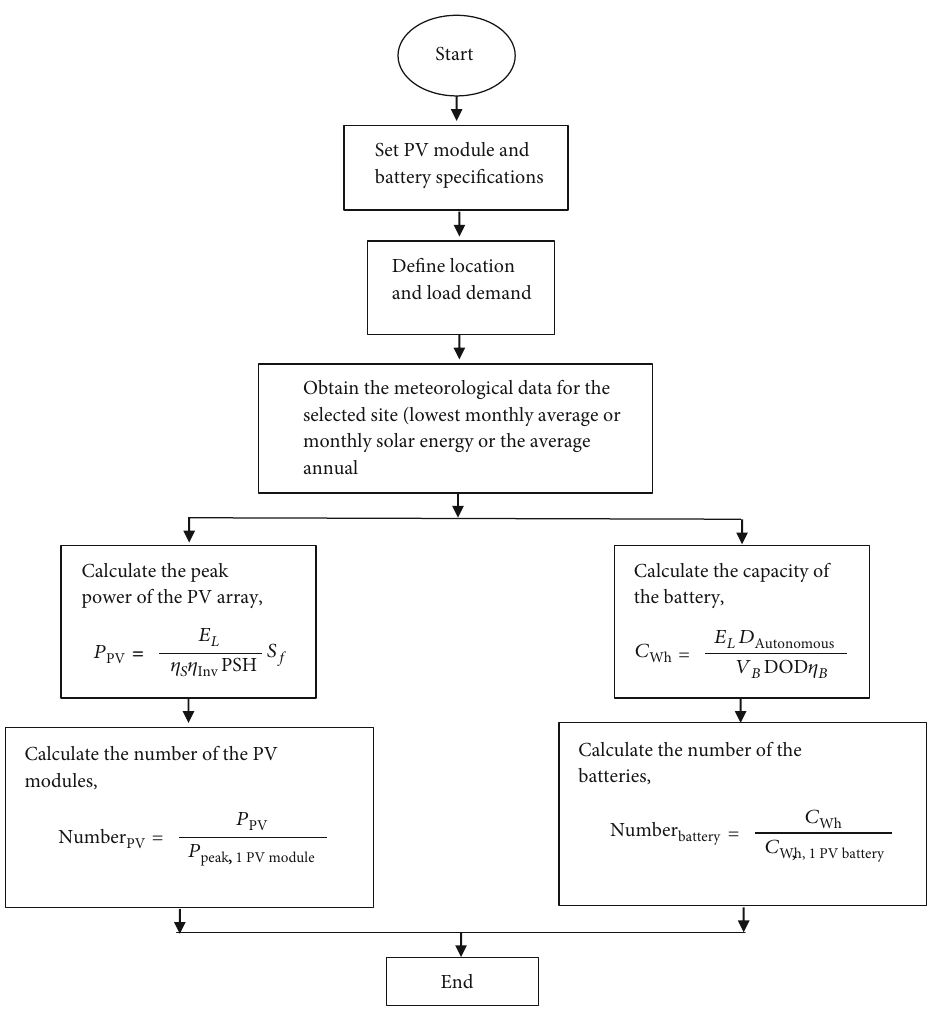
Figure 4: Intuitive method concept for designing PV-based charging system